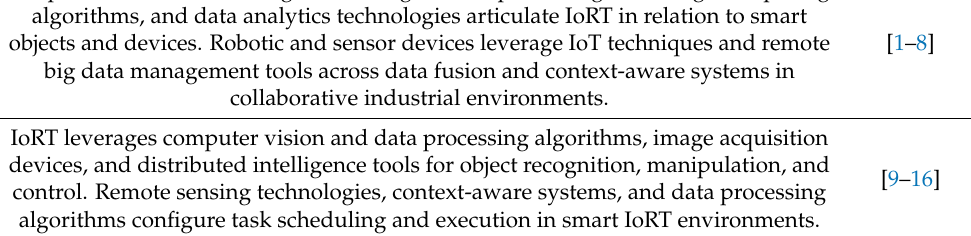
Table 3. Synopsis of evidence relating to analyzed topics and descriptive outcomes (research findings). Deep reinforcement learning and intelligent data processing tools, edge